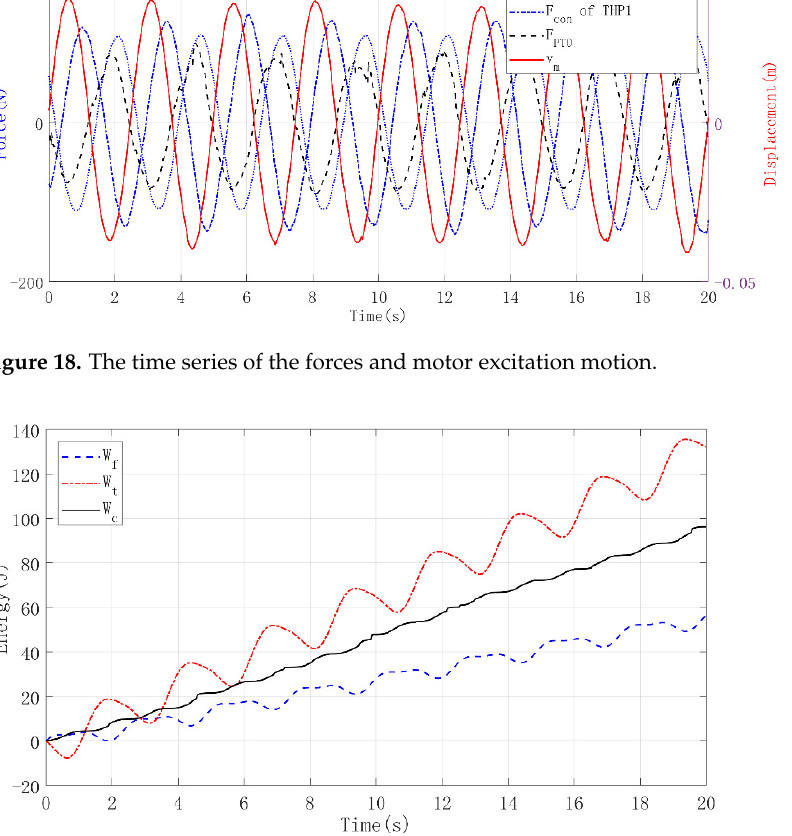
Figure 19. The consumed energies of the fixed heave plate and tuned heave plate, and the captured energy of the generator system.